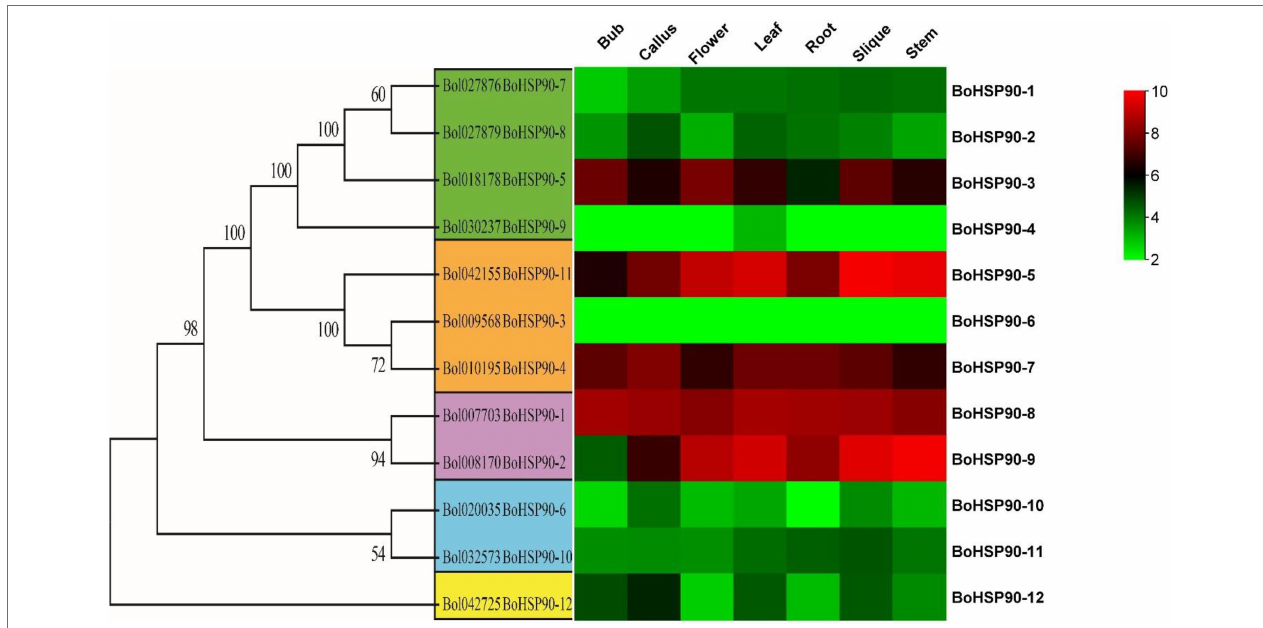
FIGURE 6 | The heat map of 12 BoHsp90 genes was constructed using Tbtools software. The FPKM values were log2 transformed and mean-centered by genes using the scale 10 for minimum expression (red color) and 2 (green color) for maximum to make a heat map visible for each cabbage tissue.